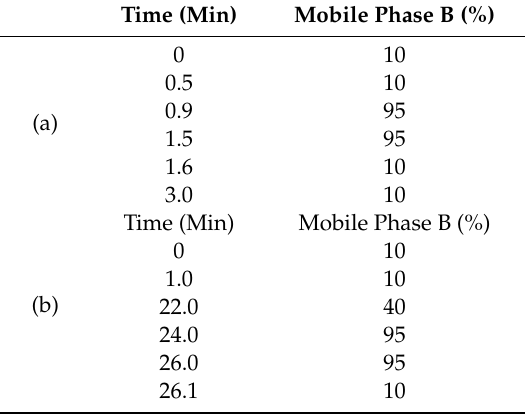
Table 9. Mobile phase condition for LC gradients. (a) LC gradient for quantification, (b) LC gradient for metabolite